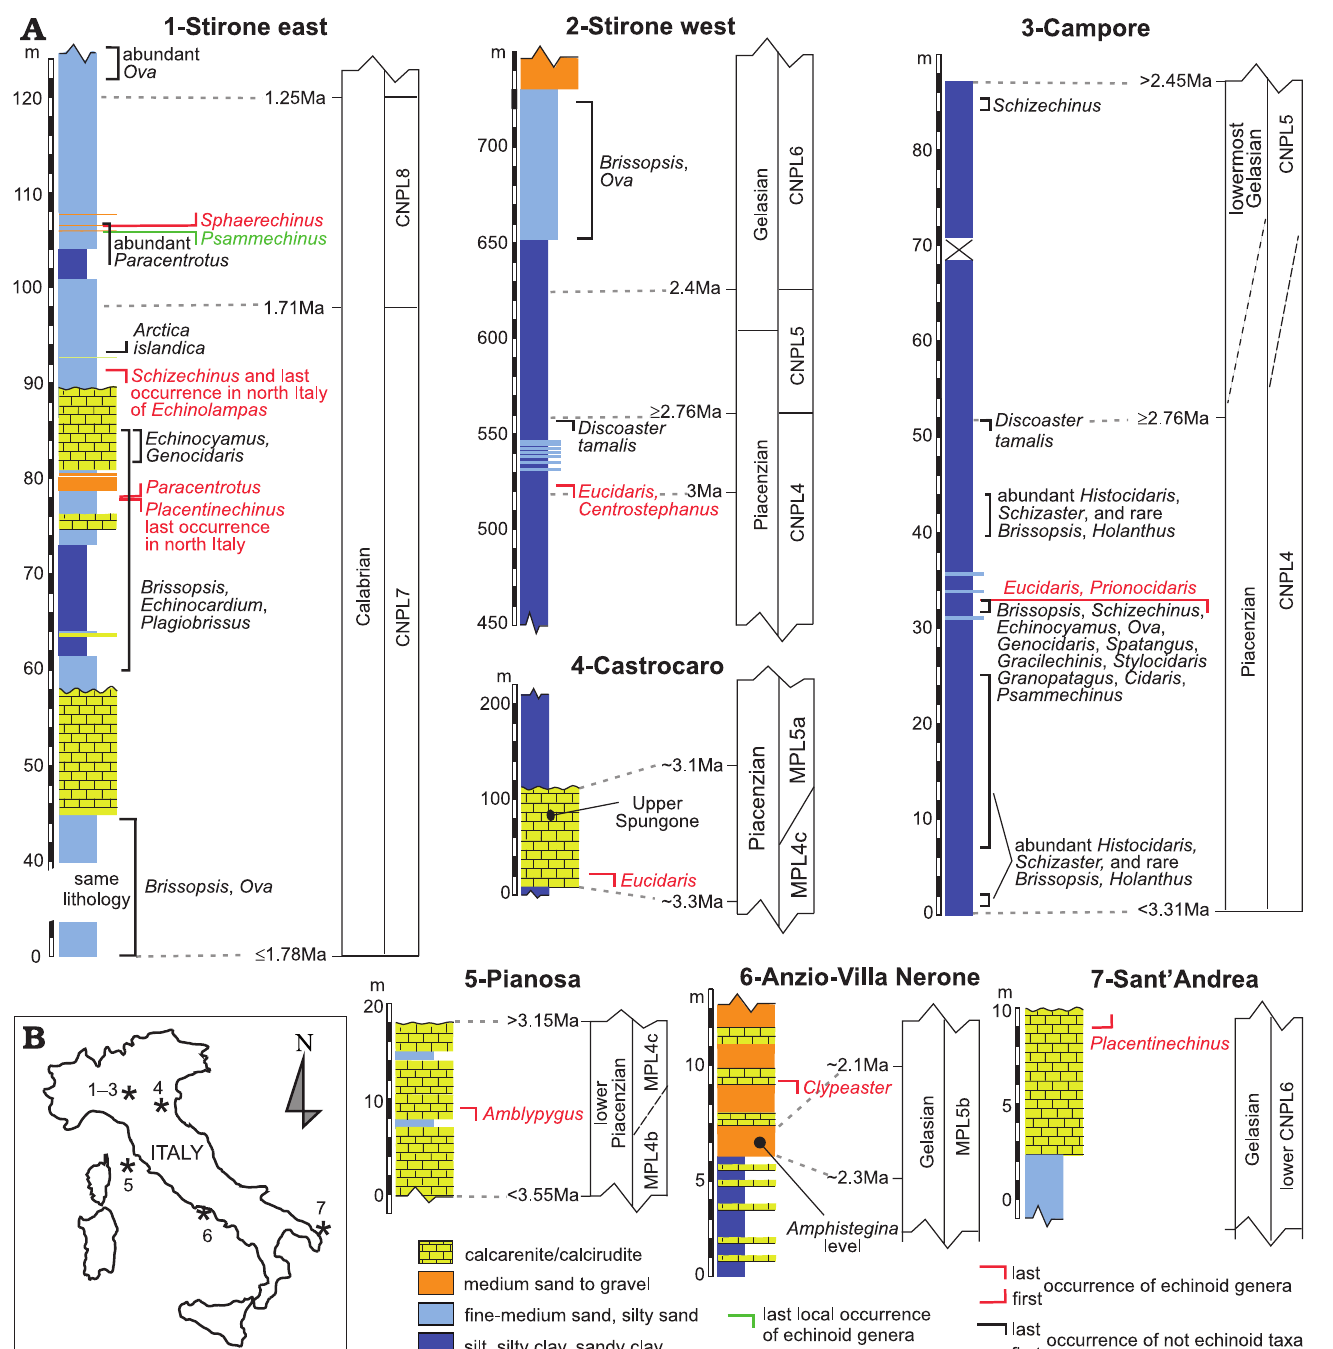
Fig. 1. Stratigraphy ( A ) and location ( B ) of some echinoid key sites from Italy , showing some of the most significant appearances, disappearances and other occurrences of Mediterranean late Cenozoic echinoids. Lithology and stratigraphy are reconstructed from Borghi and Garilli (2017) and Crippa et al. (2019) for Stirone east; Cau et al. (2015) for Stirone west; Ceregato et al. (2007) for Campore; Capozzi and Picotti (2003) for Castrocaro; Di Bella et al. (2005) for Anzio; Borghi and Garilli (2017) for Sant’Andrea. The nannofossil biozones (CNPL) and the age of Discoaster tamalis last occurrence are after Backman et al. (2012). The foraminifer biozonation (MPL) is according to Lirer et al.